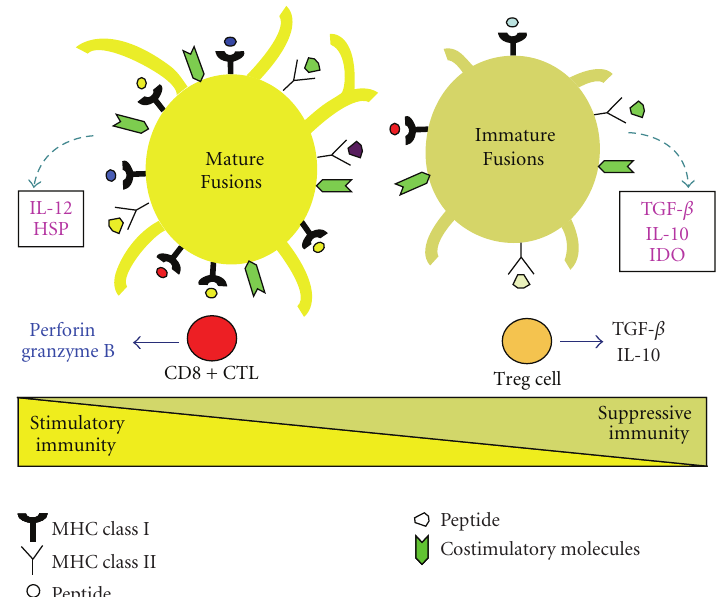
Figure 4: Activation or inactivation of T cells by tumor/DC fusions. After acquired antigens in the periphery, tumor/DC fusions migrate to the draining lymph nodes, where they encounter a cognate CD4+ or CD8+ T cells. The mature tumor/DC fusions produce stimulatory factors, such as IL-12 and heat-shock proteins (HSPs), while the immature fusions produce suppressive factors (TGF- β , IL-10, or IDO, etc.). High expression of costimulatory and MHC class I and II molecules by mature fusions is essential to promote survival and proliferative capacity of the activated CD8+ CTLs. Mature fusions induce e ffi cient CD8+ T-cell activation with high production of perforin and granzyme B. On the other hand, immature fusions may induce, at least in part, Tregs. In tumor microenvironment, the consequence of products from tumor cells enhances local suppressive